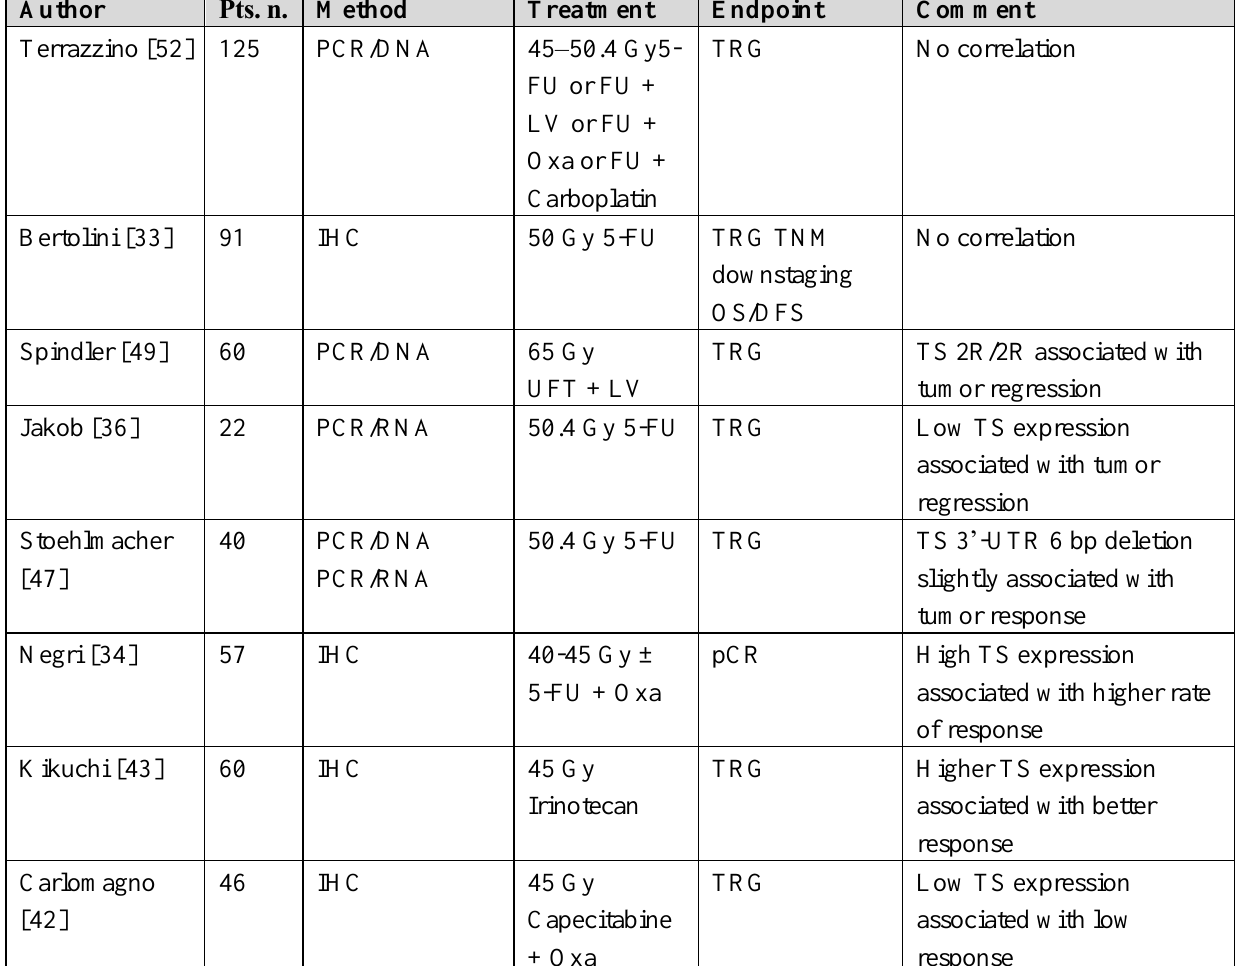
Table 2. TS expression and prediction of response to neoadjuvant radiochemotherapy in locally advanced rectal cancer